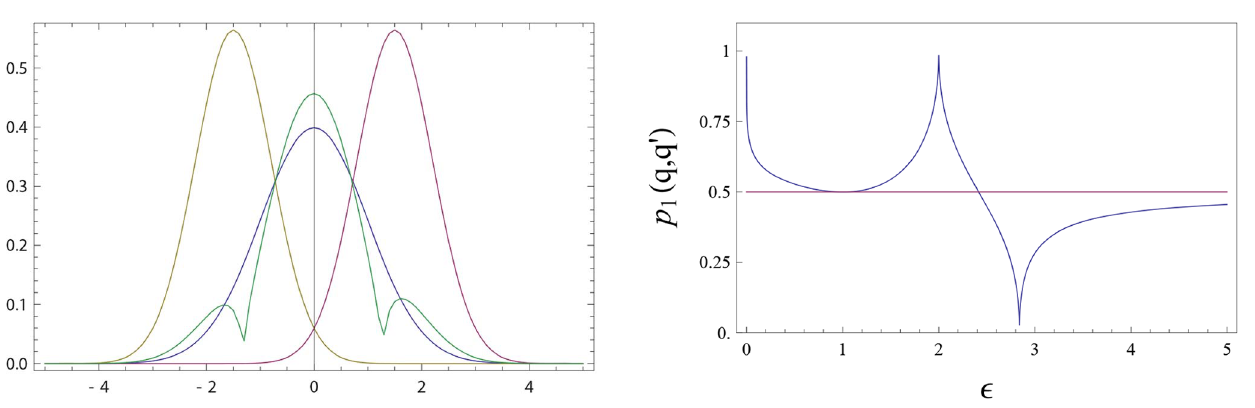
g ( E ) behaves as a function of E . g ( E ) z 1 p ffiffiffi 2 ; for E w 2 z